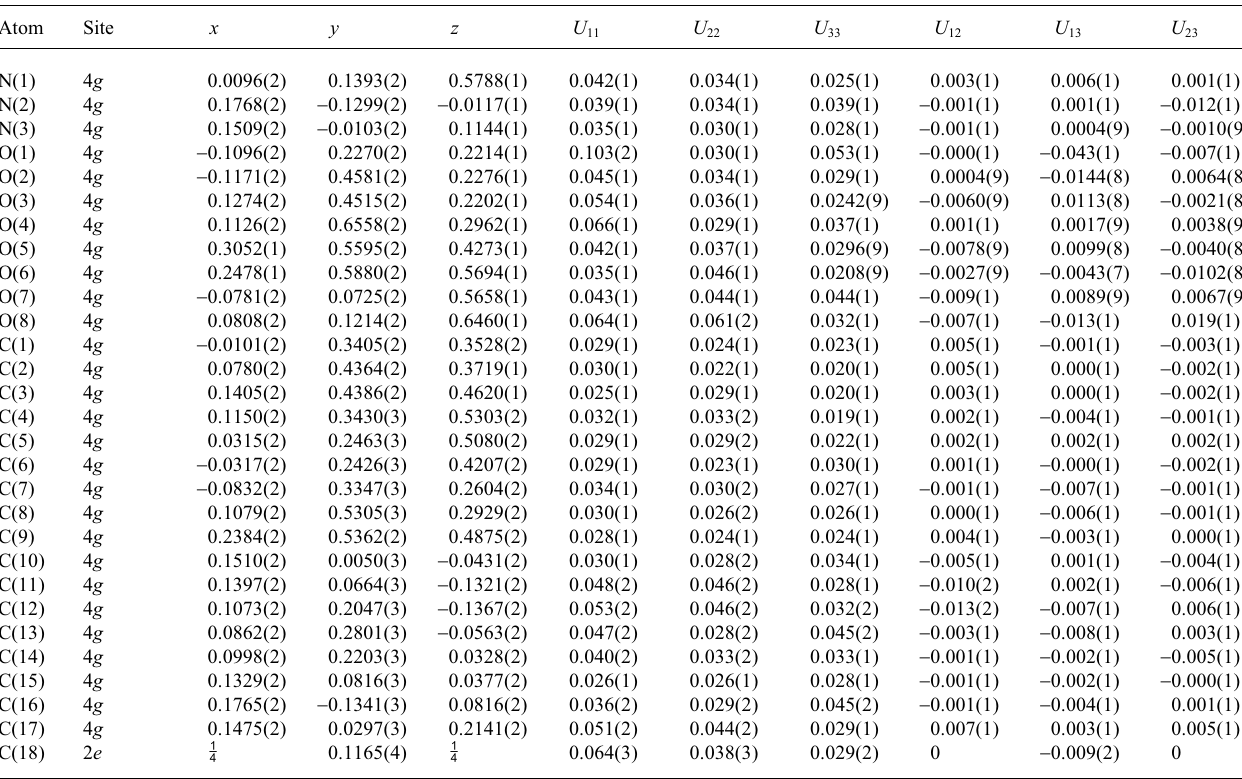
Table 3. Atomic coordinates and displacement parameters (in Å 2 ) .